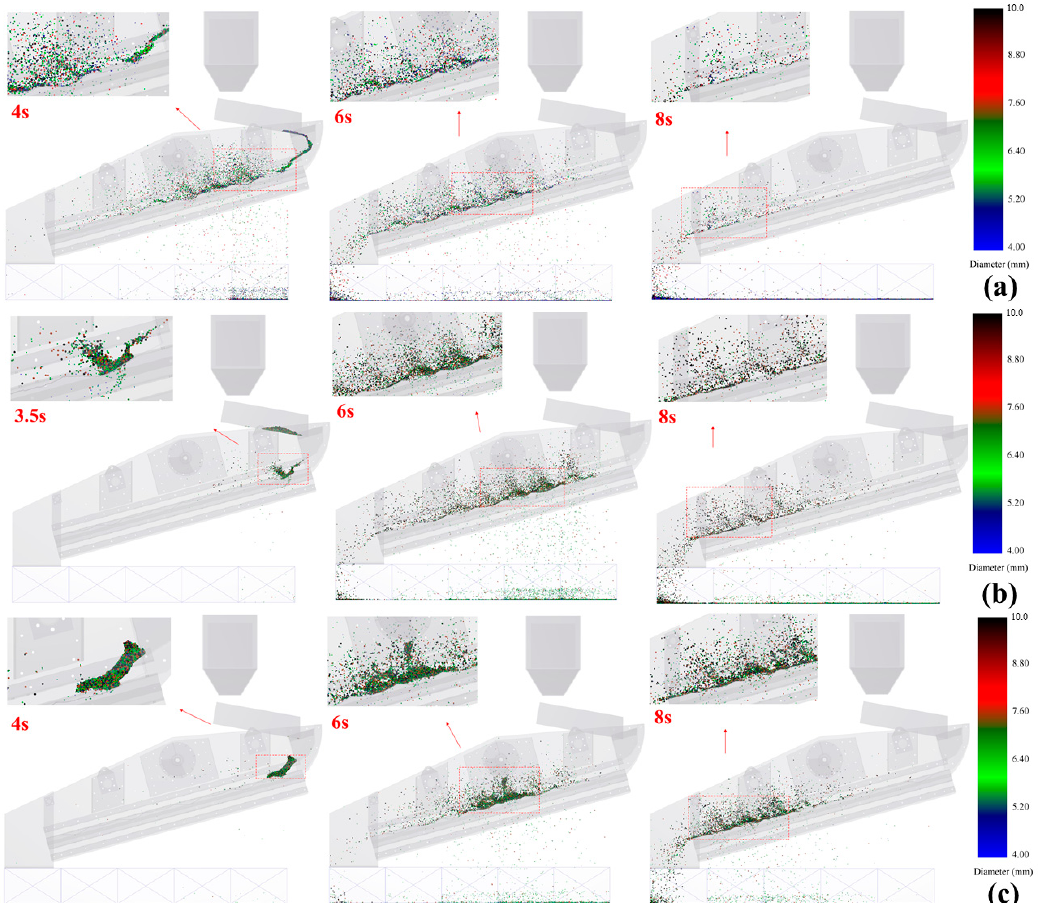
Figure 7. The flow behavior of material on VFFS with different surface energy levels. ( a ) 4, ( b ) 20, and ( c ) 36 J/m 2 .